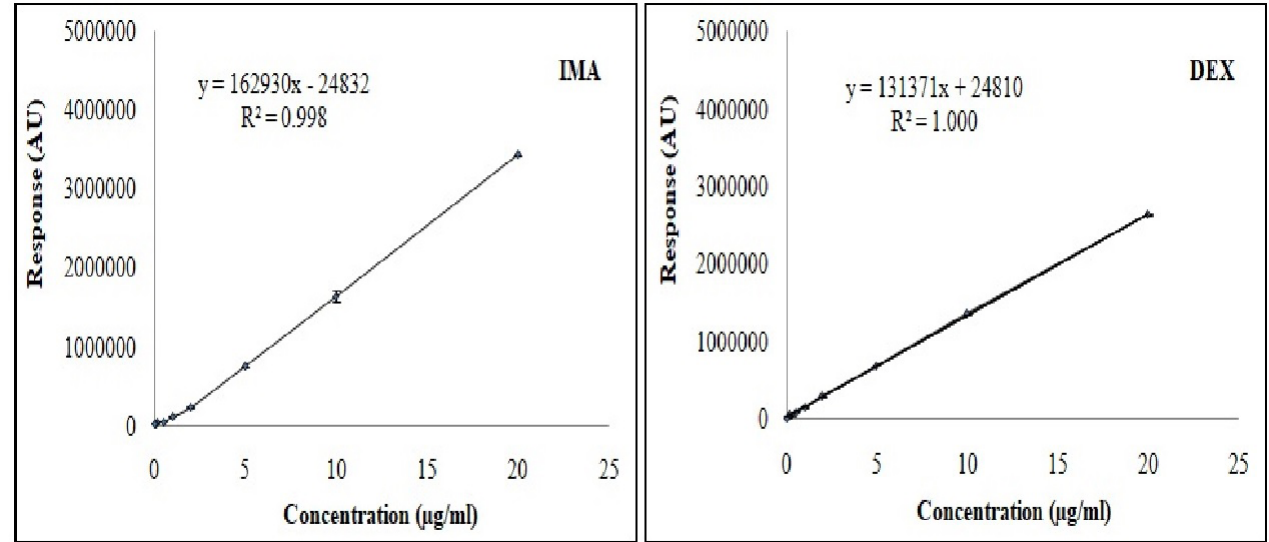
FIGURE 4 - The calibration curves of imatinib mesylate and dexketoprofen trometamol in phosphate buffer